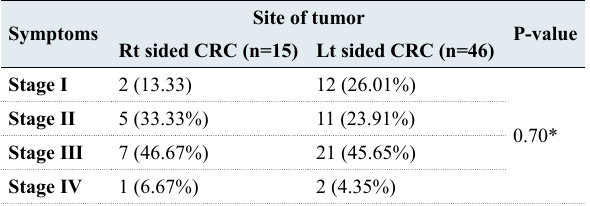
Table 4: Tumor stages as per tumor location in CRC in the study